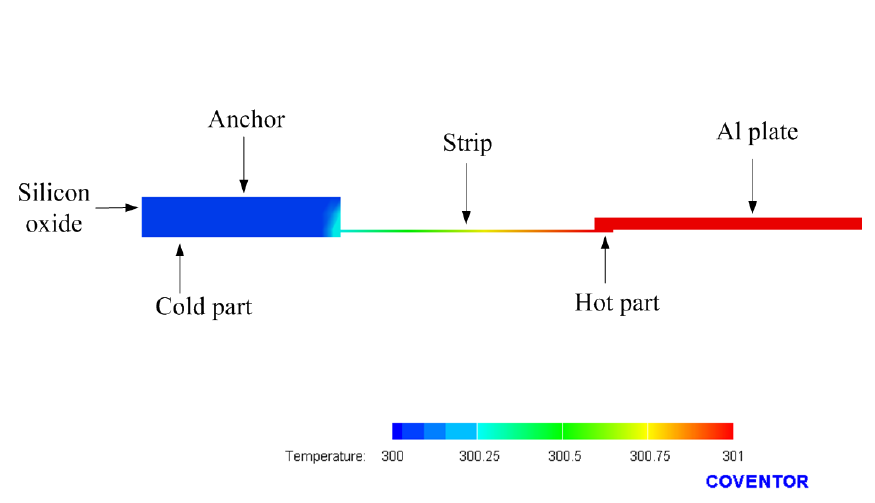
Figure 3. Cross-sectional view of temperature distribution for the generator.